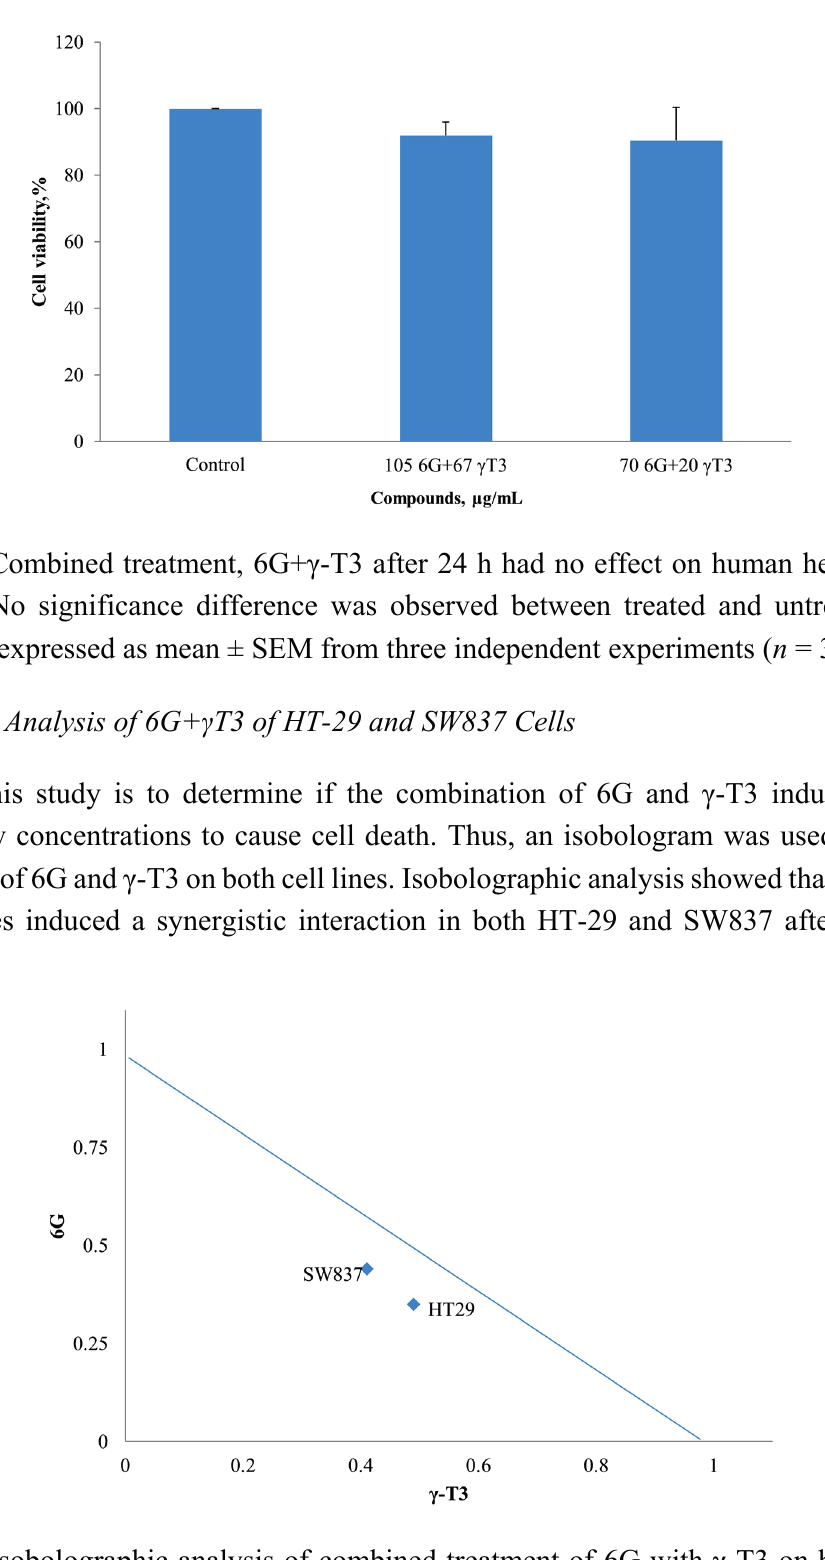
Figure 4. Isobolographic analysis of combined treatment of 6G with γ -T3 on both HT-29 (CI = 0.89) and SW837 (CI = 0.79). The line represents as a line of additivity. Values below the line indicates synergistic interaction (CI < 1), while above is considered as antagonistic interaction (CI > 1) with values on the line indicating additive interaction (CI =